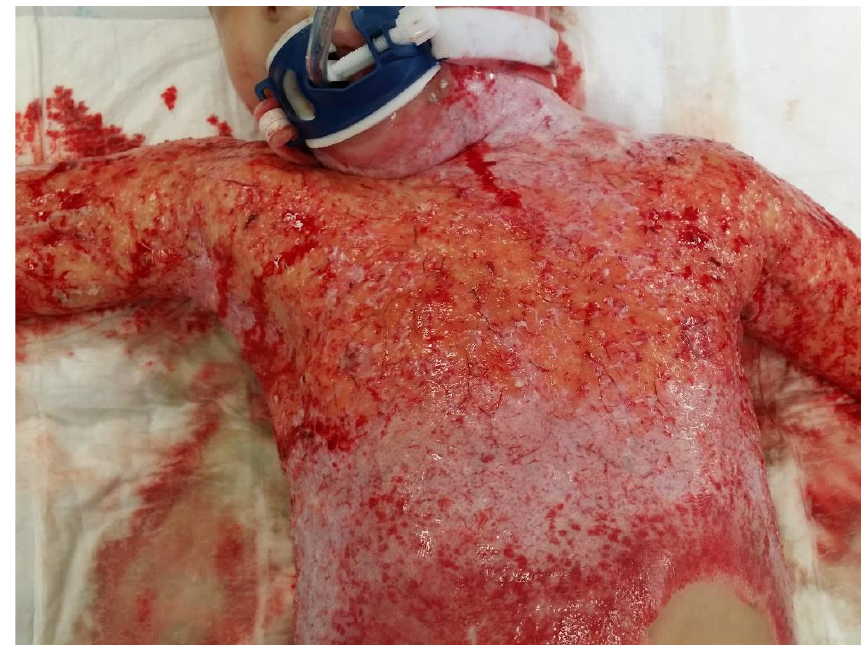
Figure 3. Result of enzymatic debridement.